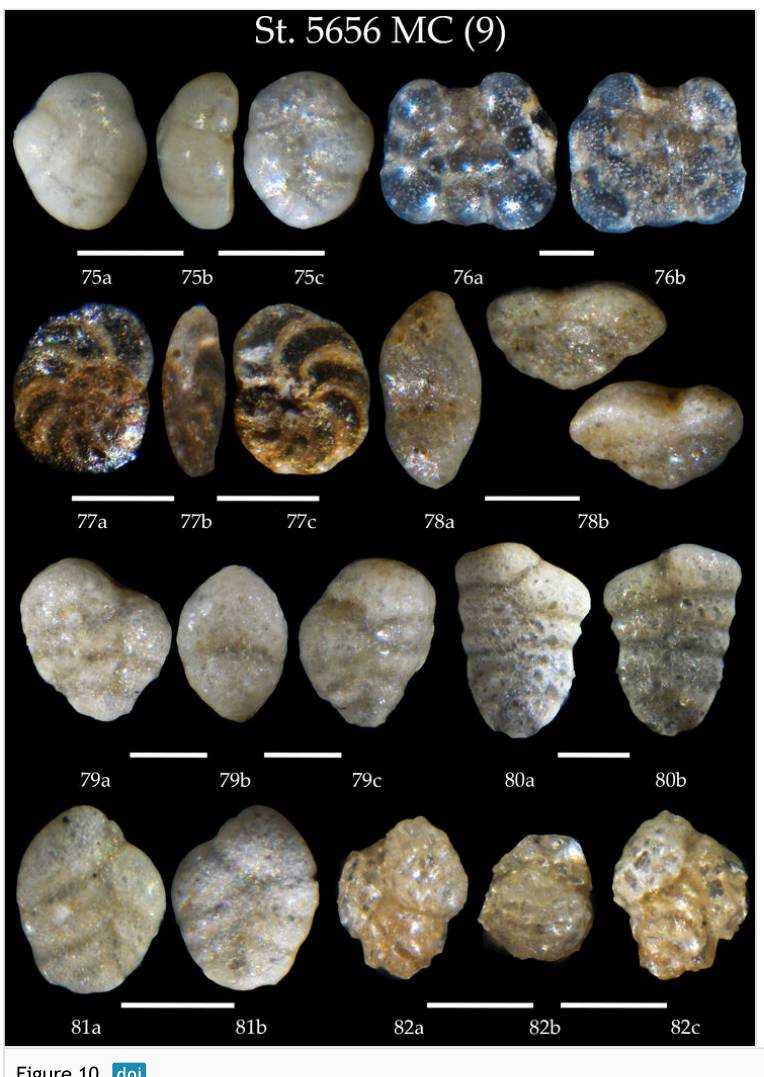
Figure 10. Station 5656 MC (continued). 75 Sp. cf. C. lobatulus juvenile test, a spiral view, b apertural view, c umbilical view; 76 Planorbulina mediterranensis , a spiral view, b umbilical view; 77 Discorbis sp., a spiral view, b apertural view, c umbilical view; 78 Sahulia conica , a apertural view, b side view; 79 Sahulia conica , a, c side view, b apertural view; 80 Textularia sagittula , a side view, b lateral view; 81 Siphotextularia concava , a side view, b lateral view; 82 Eggerelloides scaber , a, c side view, b apertural view. Scale 100